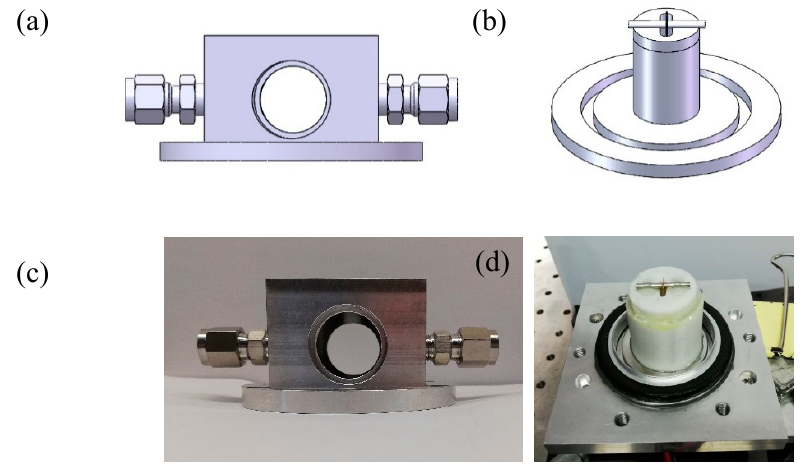
Figure 7. ( a ) CAD image of the KF40 vacuum cap; ( b ) CAD image of the KF40 vacuum base; ( c ) Photo of the KF40 vacuum cap; ( d ) Photo of the KF40 vacuum base.